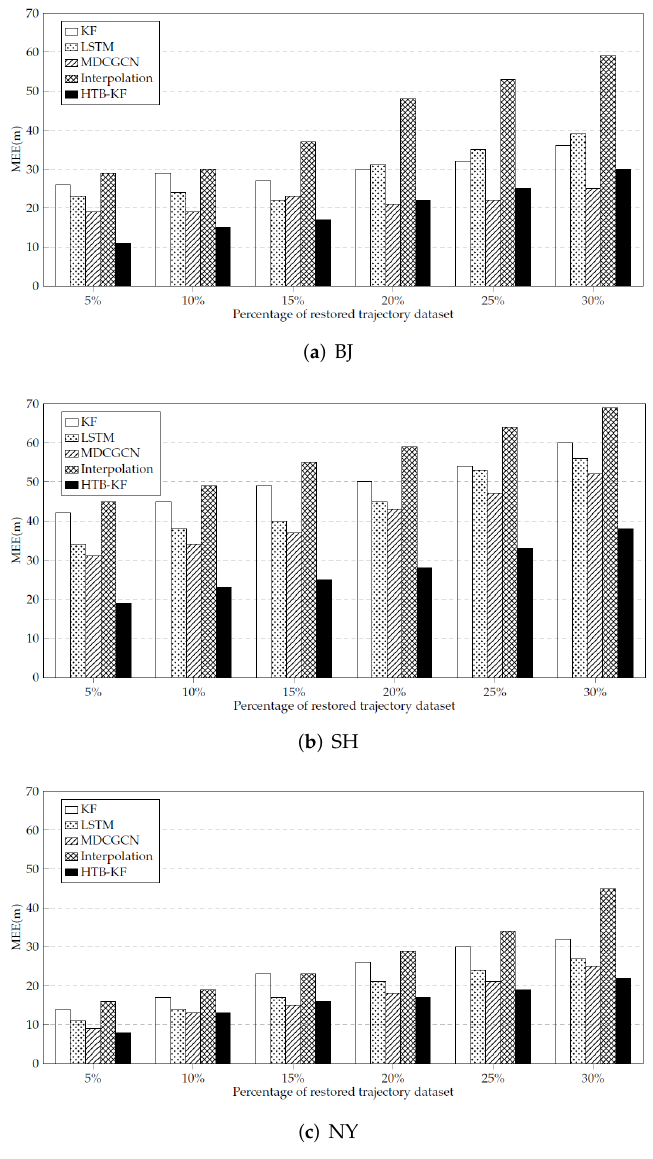
Figure 9. MEE results of different algorithms for the number of missing trajectory datasets. ( a ) Trajec- tory restoration based on Beijing city. ( b ) Trajectory restoration based on Shanghai city. ( c ) Trajectory restoration based on New York